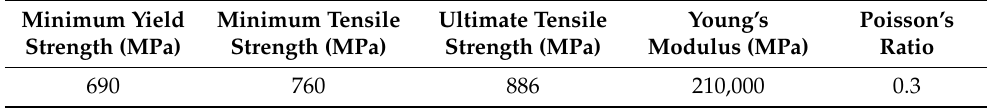
Table 1. Performance parameters of X100 pipeline steel.